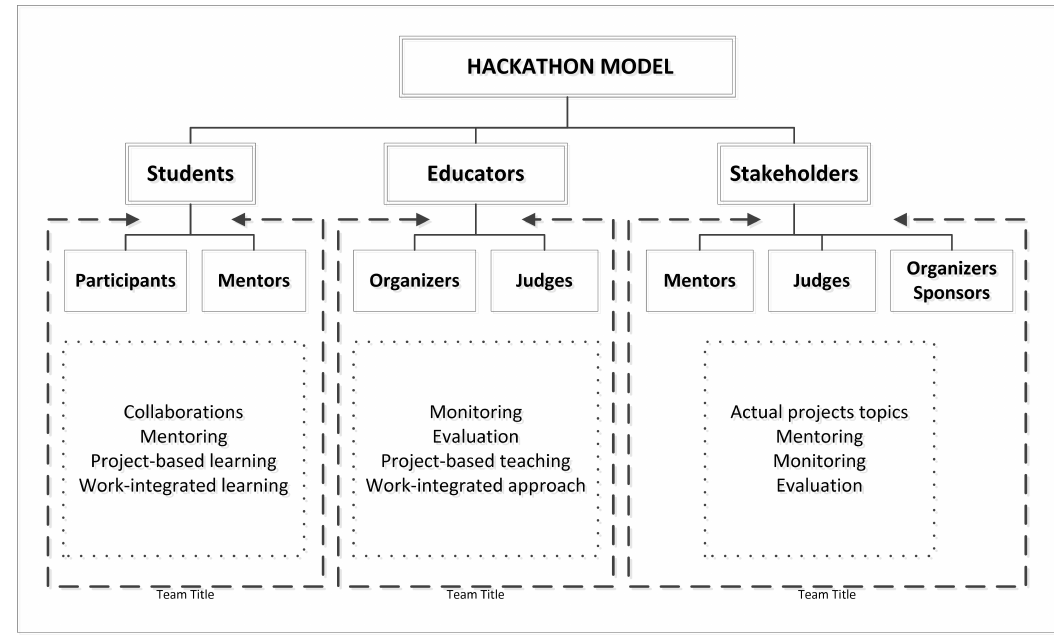
Figure 3: Hackathon